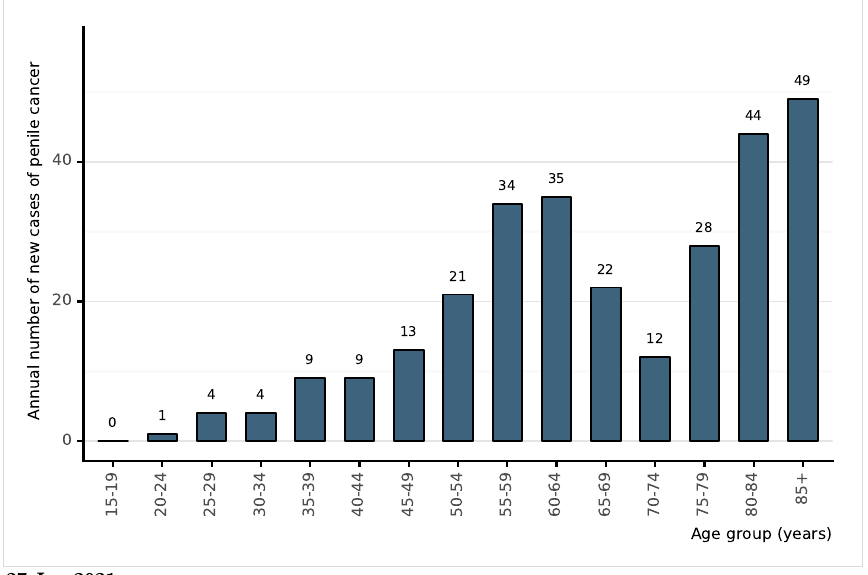
Figure 32: Annual number of new cases of penile cancer in Peru (estimates for